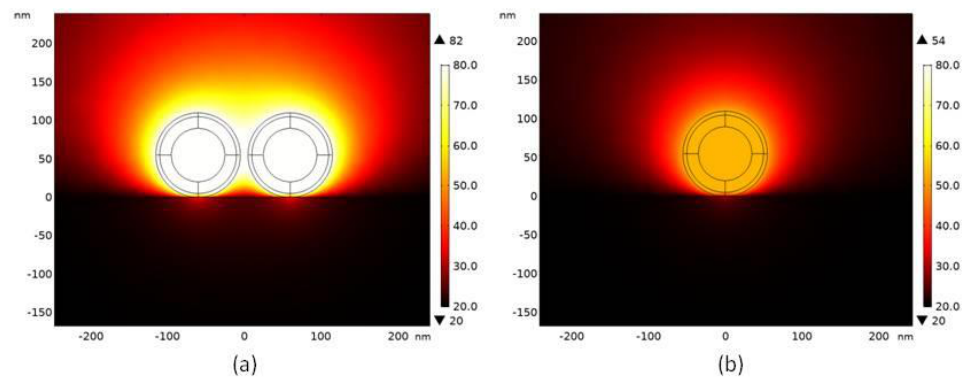
Figure 8. FEM simulation results for the dimer structure ( a ) and for the single nanoparticle ( b